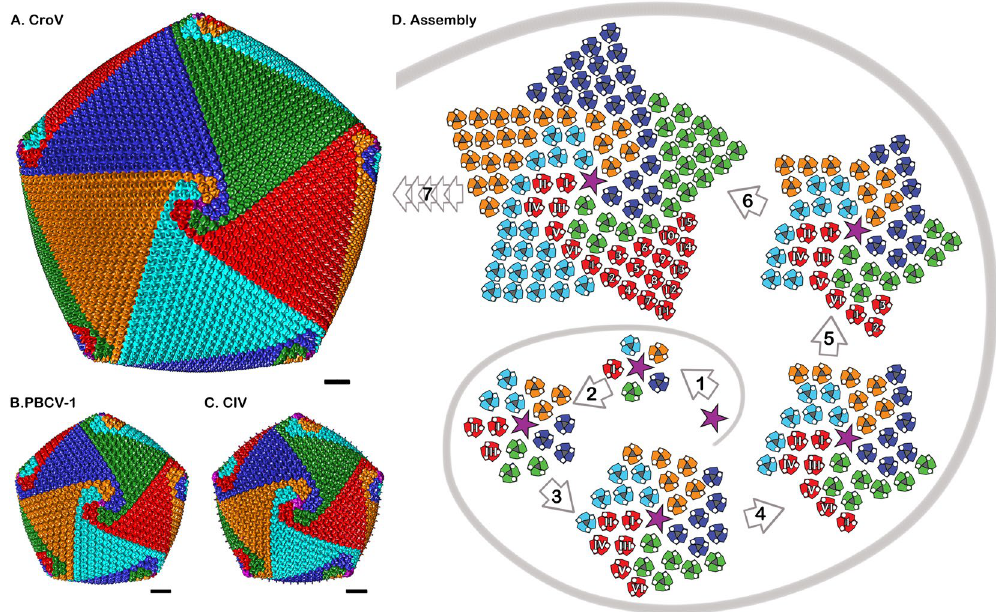
Figure 4. The proposed spiral assembly pathway of large icosahedral capsids. Isosurfaces of CroV ( A ), PBCV-1 ( B ), and CIV ( C ) cryo-EM maps were centered on the 5-fold axis. Capsomers in all three panels are colored based on their orientation in red, blue, green, cyan, and orange. The pentameric capsomers are depicted as purple stars. ( D ) Schematic diagram showing the right-handed spiral assembly pathway following arrows (1) to (6), with multiple extensions (7) of the trisymmetrons to form similar patterns as shown in ( A – C ). One set of capsomers (red) is labeled by Roman numerals if they are part of the pentasymmetron and by Arabic numerals if they are part of a